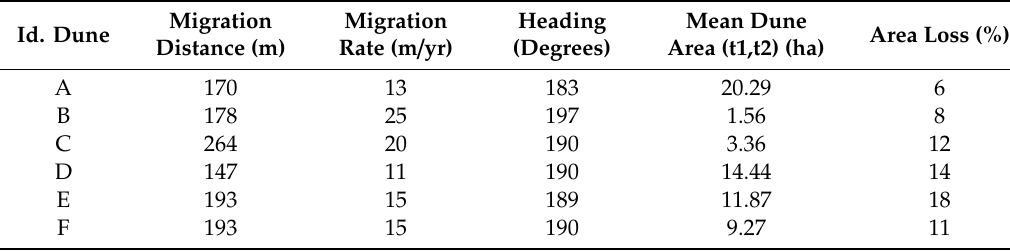
Table 4. Dune migration information obtained using the automatic method over the reference dunes (manually delineated) from the WSM dune field, obtained between 2003 and 2015, specifying distance, velocity, heading direction, mean area and area loss.